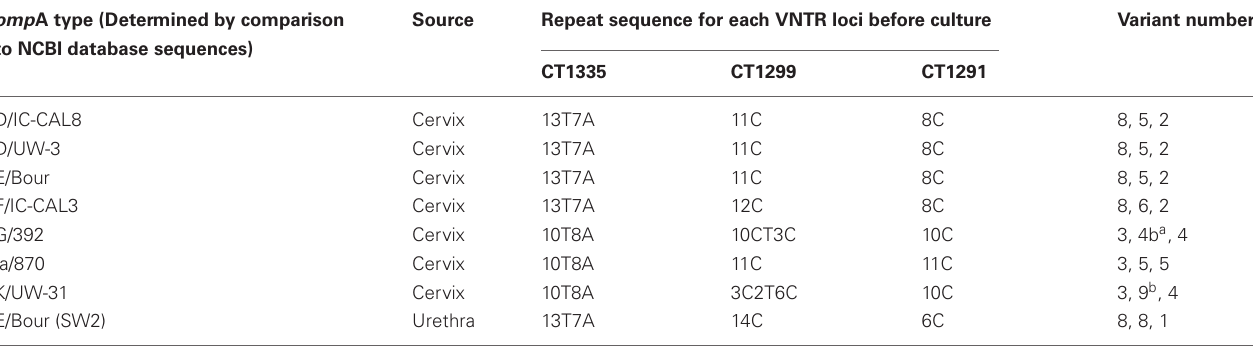
Table 1 | Isolates included in all studies and their sites of isolation, also included are the repeat sequences for the three VNTR loci, their associated variant number, and the corresponding omp A NCBI database strain type for each isolate before culture.